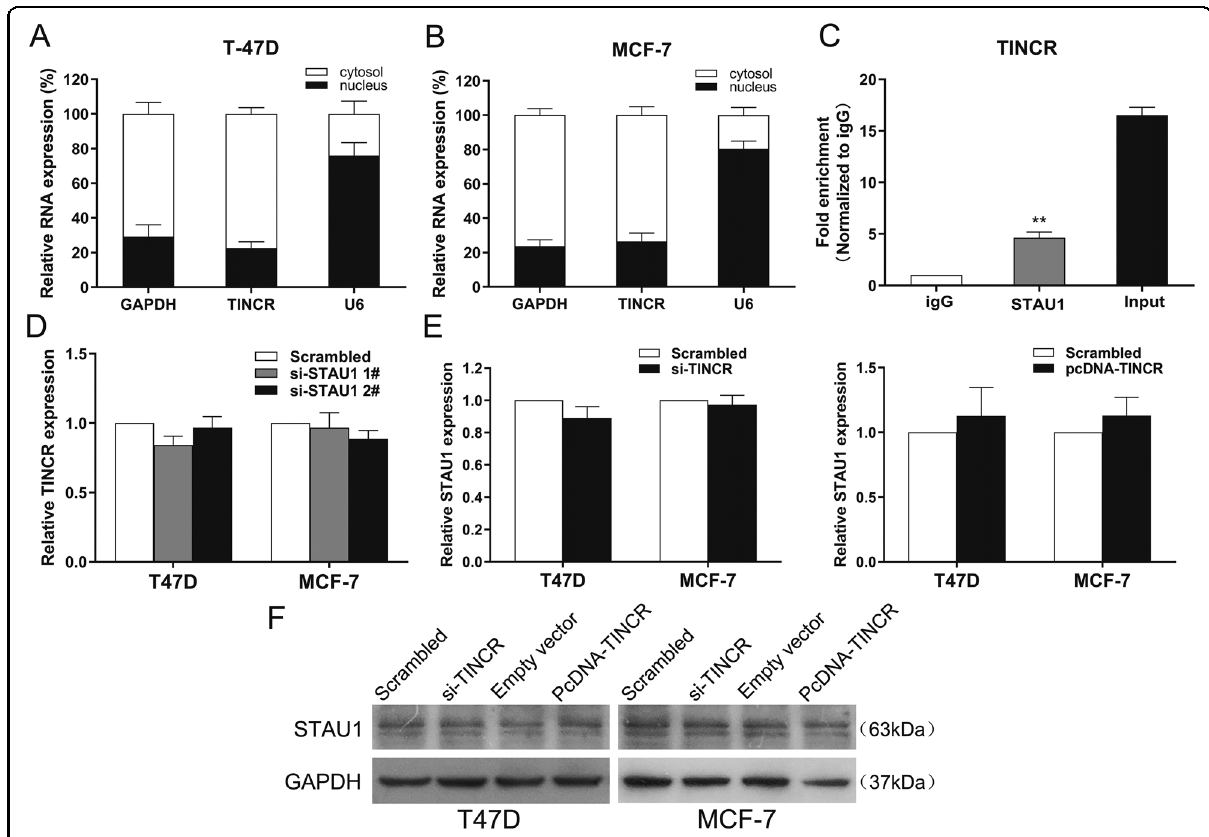
Fig. 5 TINCR can bind to cytoplasmic protein STAU1. A, B qRT-PCR assays were performed to reveal the expression levels of TINCR in the cytoplasm or nucleus of T47D and MCF-7 cells. GAPDH was used as a cytosol marker and U6 was used as a nuclear marker. C RIP assay was performed with IgG or STAU1 antibodies in T47D cells, and the coprecipitated RNA was subjected to qRT-PCR for TINCR. D qRT-PCR assay examined TINCR expression in breast cancer cells transfected with control (scrambled), si-STAU1 1# and si-STAU1 2#. E qRT-PCR assay examined STAU1 expression in breast cancer cells treated with si-TINCR or pcDNA-TINCR. F Western blot assay examined STAU1 expression in breast cancer cells treated with si-TINCR or pcDNA-TINCR. Values are shown as the mean ± s.d in three independent experiments. The mean values of two groups were compared via paired, two-tailed Student t tests.* P < 0.05, ** P <